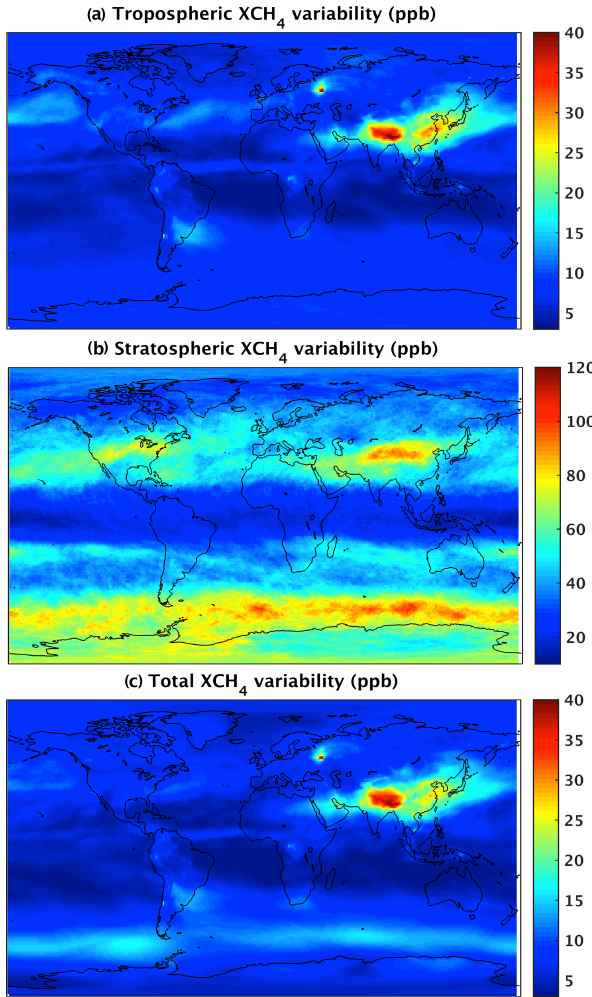
Figure 1. Mean column abundance of CH 4 (inppb) during June– August 2010 obtained from the C-IFS fields for (a) tropospheric partial column, (b) stratospheric partial column and (c) total col- umn. Note the different colour scales in the three panels.